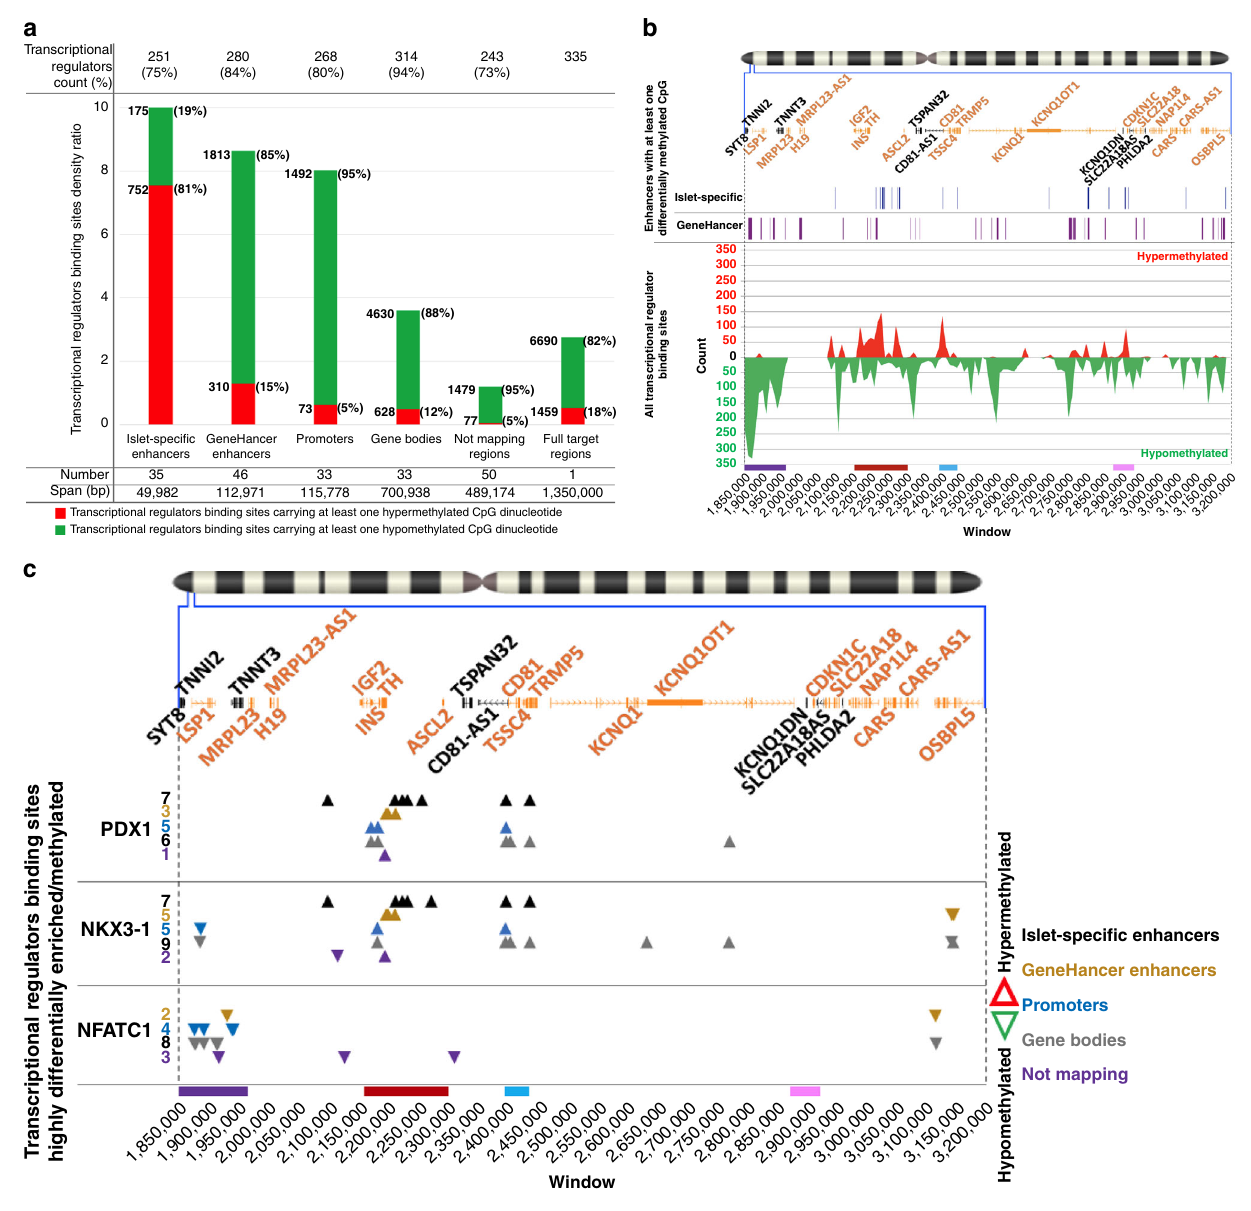
Fig. 6 Mapping transcriptional regulator binding sites by genomic elements. a Histogram of transcriptional regulators by genomic elements. The X axis lists the same genomic elements of the target region in Fig. 1c. The Y axis reports the ratio of the cumulative length of the binding sites mapping in each region over the cumulative length of the region itself. The red and green coloring of the histogram refers to the proportion of hypo- and hypermethylated sites. Each red and green portion of each histogram bar is labeled with the number of hypo- and hypermethylated binding sites. Above the histogram, for each genomic element, the count and percentage are shown for the number of transcriptional regulators per genomic element. Below the histogram, the number of genomic elements and their total span, in base pairs, is also shown (Supplementary Data 18). b Top panel: The chromosome 11 ideogram with a magni fi cation of the 11p15.5-p15.4 target sub-region as described in Fig. 1a. Middle panel: Tracks showing the distribution of 35 islet-speci fi c enhancers (blue track) and 46 generic, GeneHancer enhancers (purple track). Bottom panel: The X axis represents a breakdown of the 1.35 Mbp target sub-region in 135 windows of 10 kbp each. The Y axis shows the count, per window, of all differentially methylated transcriptional regulator binding sites. Above and below the “ 0 ” black line, the count of hypo- and hypermethylated transcriptional regulator binding sites are reported as peaks. Note the lack of overlap between islet-speci fi c and GeneHancer enhancer and, conversely, the strong overlap between islet-speci fi c enhancers and dark red and purple regions shown in the bottom of the fi gure (see Supplementary Data 18 for details). c Map of binding sites for the transcriptional regulators in Fig. 5 by the genomic elements in a . The X axis provides a reference for the position of the transcriptional regulator binding site across the target region. The Y axis shows the transcriptional regulators for the dark red (PDX1, NKX3-1) and purple (NFATC1) regions. Each row provides the mapping of the signi fi cant differentially methylated binding sites by genomic elements (see Supplementary Data 18 for